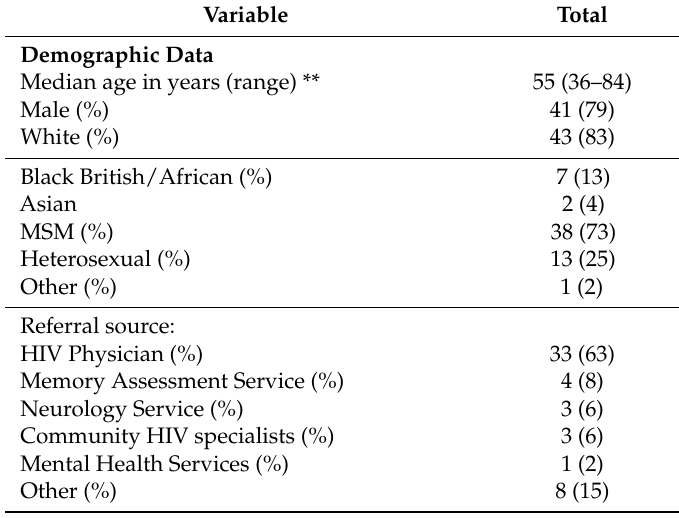
Table 2. Demographic, HIV and health data of patients attending the